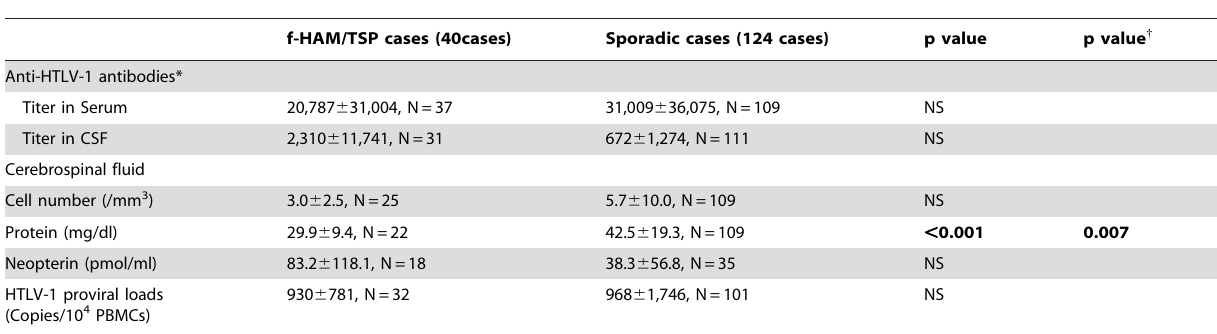
Table 2. Laboratory findings of familial clusters or sporadic cases of HAM/TSP.